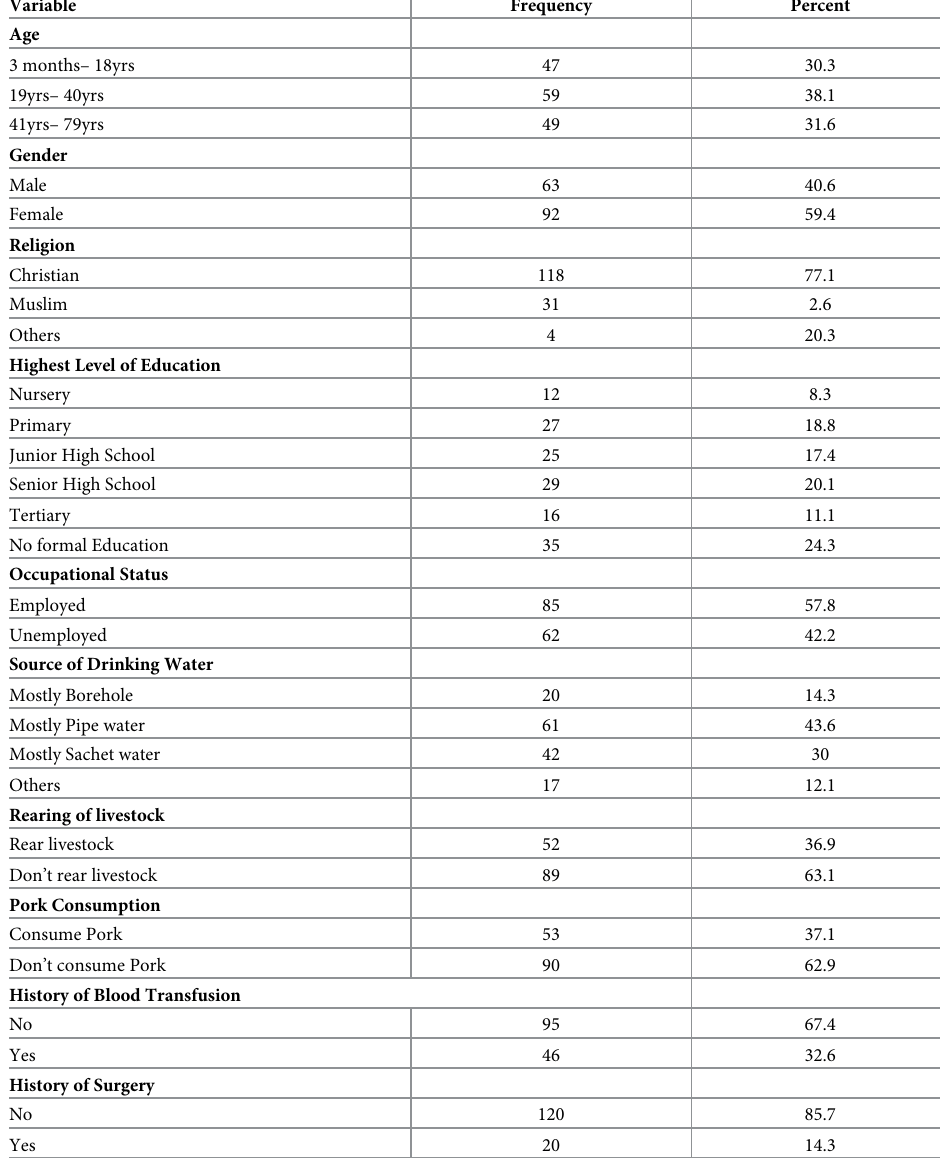
Table 2. Socio-demographic characteristics of